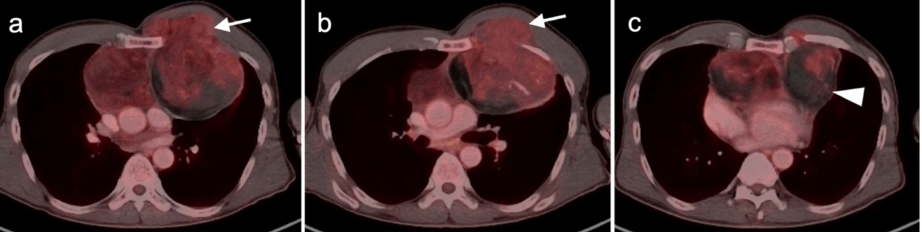
Figure 23. Dedifferentiated liposarcoma of the mediastinum arising from a low-grade liposarcoma. A large anterior mediastinal/chest wall mass had been present for many years but had recently increased in size and become symptomatic. ( a – c ) Axial FDG PET-CT images of the chest show a heterogenous mass in the anterior mediastinum with invasion of the left anterior chest wall (white arrows). ( c ) Hypometabolic regions of low attenuation (white arrowhead) were also present. Metabolically active regions were targeted at biopsy, revealing dedifferentiated liposarcoma arising from a low-grade